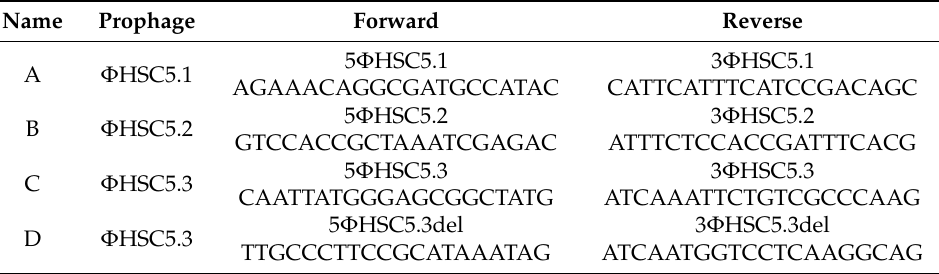
Table 2. Primers used to determine the presence of